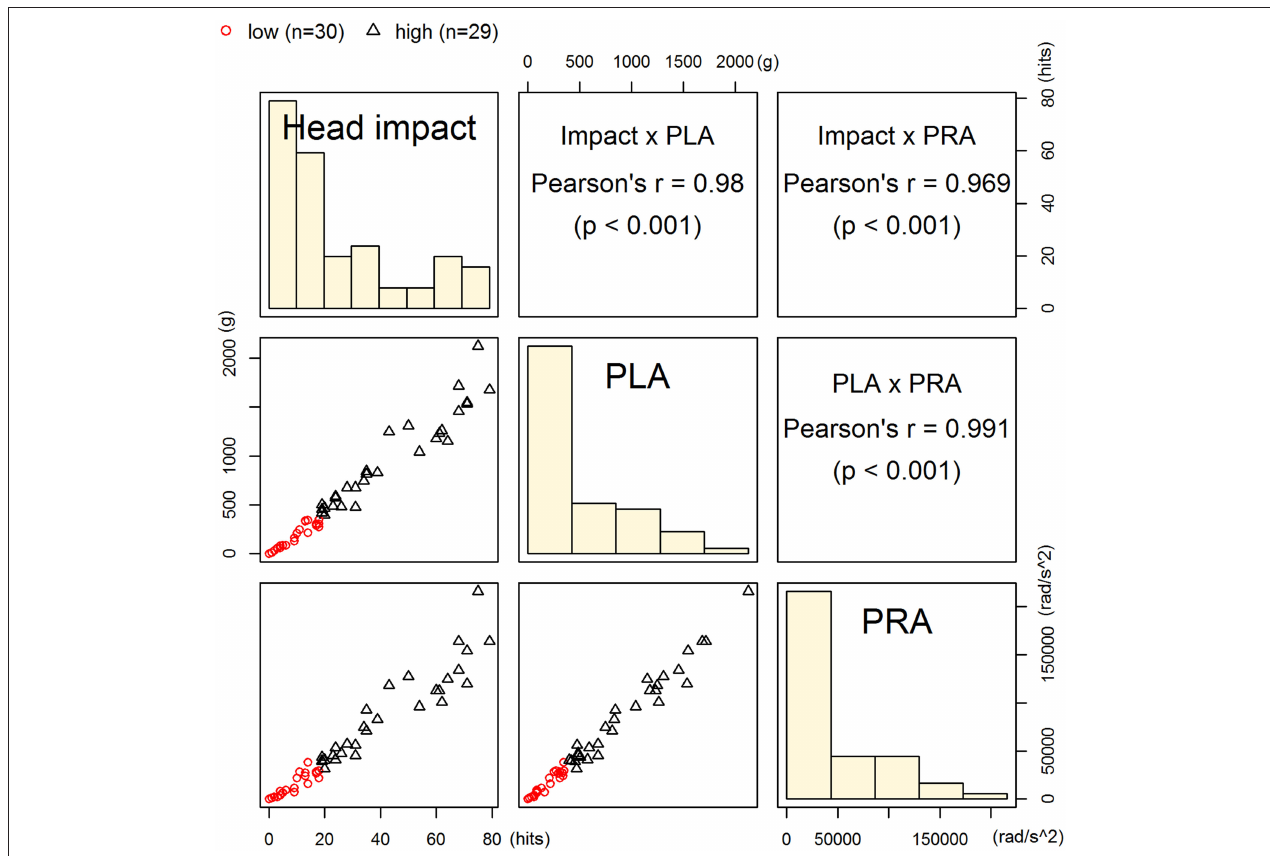
FIGURE 3 | Classification of high- and low-impact groups. Players’ data points from 5 games ( n = 59) were categorized into high ( n = 30) or low impact group ( n = 29) using k -means clustering on head impact count, peak linear acceleration, and peak rotational acceleration. These kinematic parameters were significantly correlated to one